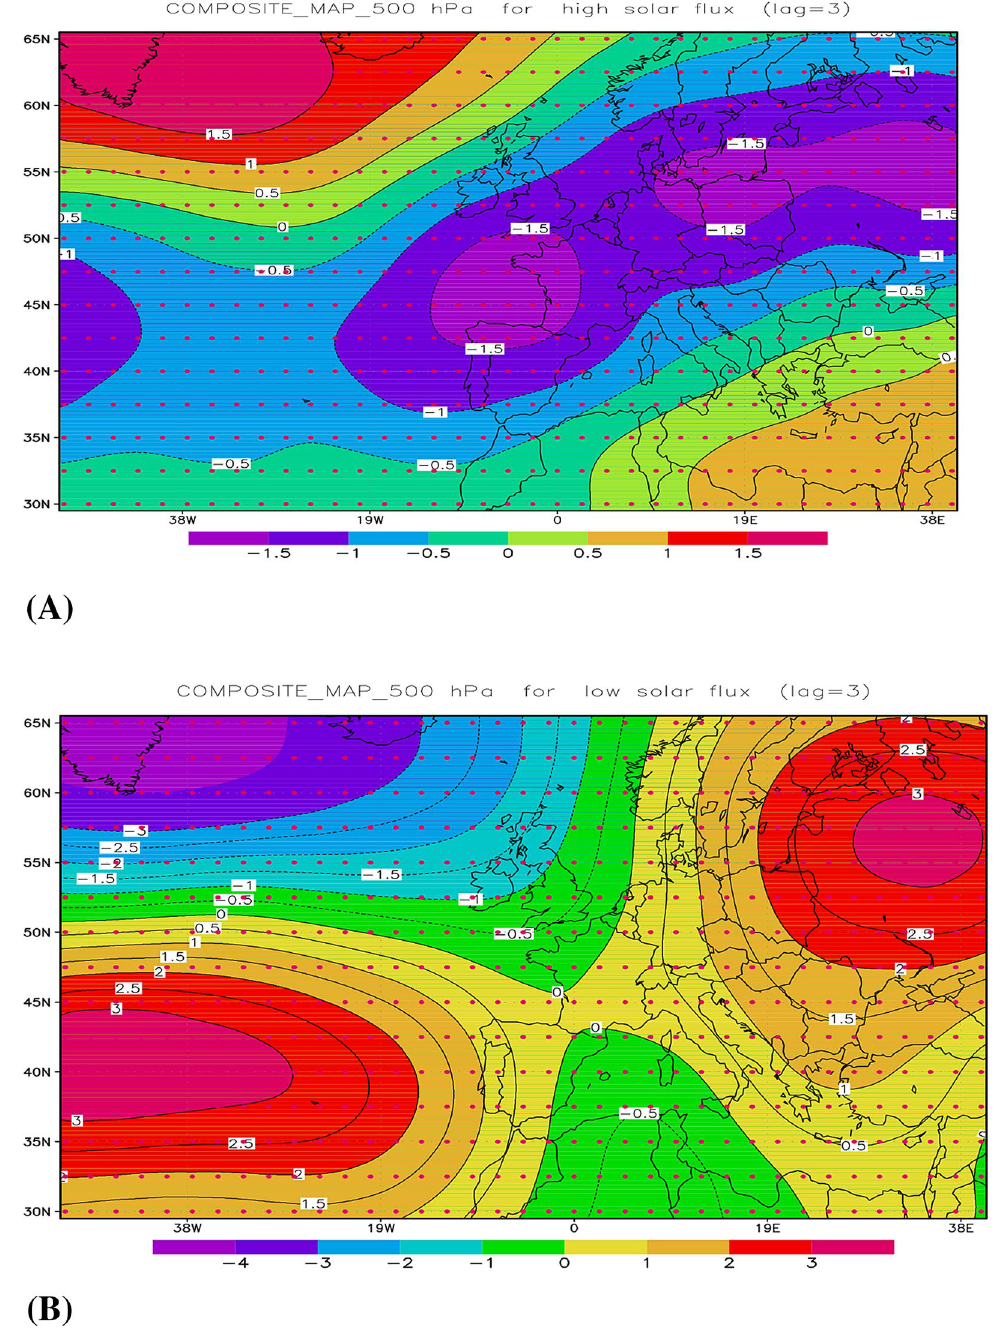
Figure 5. Composite maps for winter anomalies at 500 hPa, corresponding to the solar flux leading with 3 years the geopotential for two cases: ( A ) high flux; ( B ) low